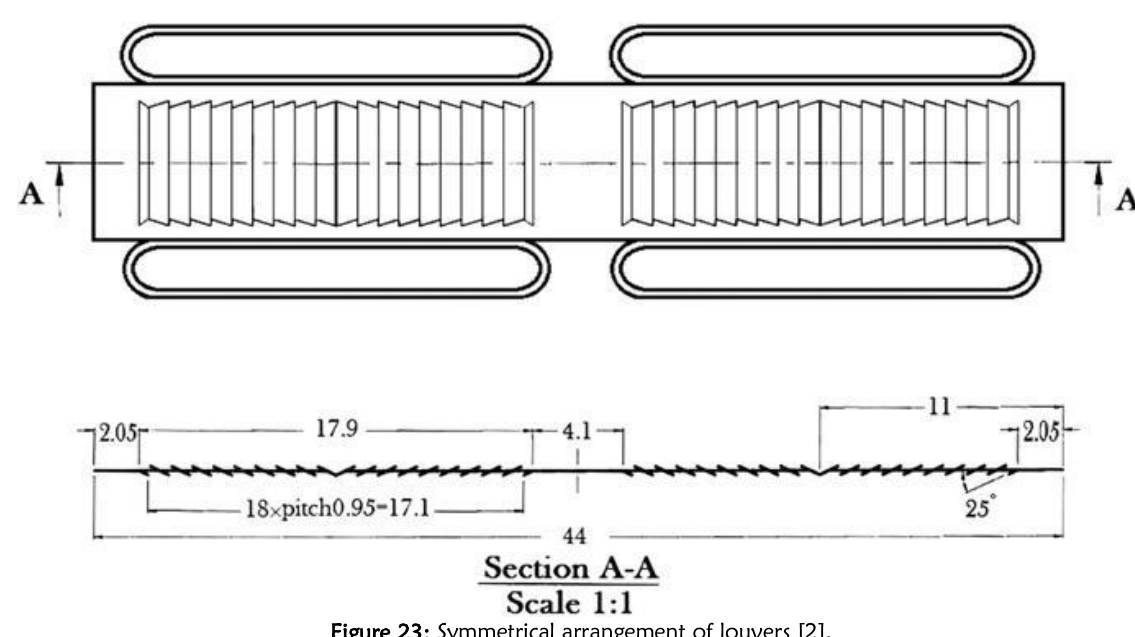
Figure 23: Symmetrical arrangement of louvers [2].